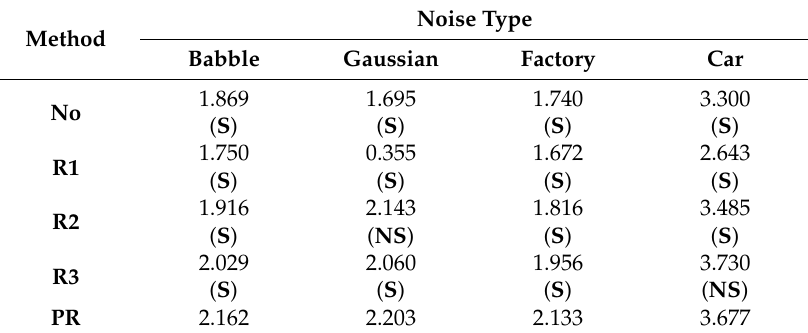
Table 4. The comparison of PESQ scores for di ff erent approaches, averaged over [10, 5, 0, − 5]